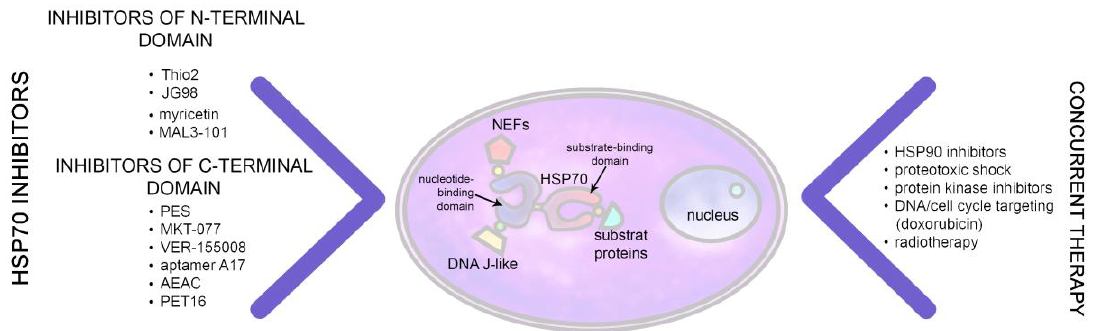
Figure 4. Concurrent application of HSP70 inhibitors and anti-tumor therapies. 356